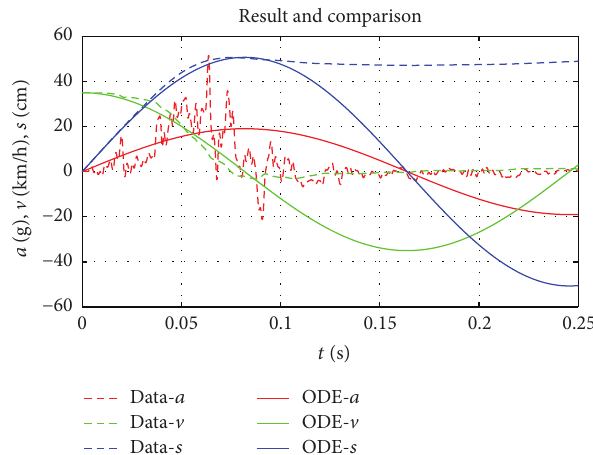
Figure 8: Results and comparison between Kelvin model and crash